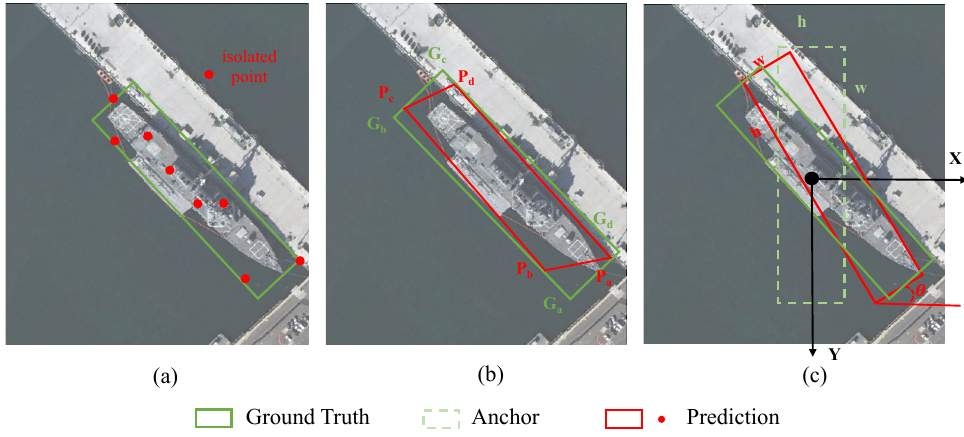
Figure 1. Illustrations of different problems for different representations: ( a ) Dissociation of PointSet; ( b ) Representation ambiguity of QBB; ( c ) Boundary discontinuity of